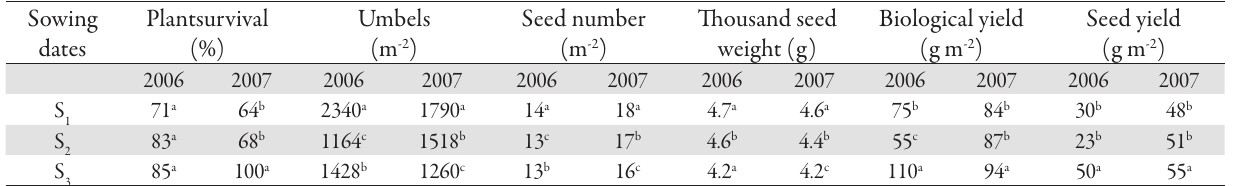
Tab. 2. Effects of different sowing dates on plant survival, number of umbels, seed number, thousand seed weight, biological and seed yield of cumin ( Cuminum cyminum